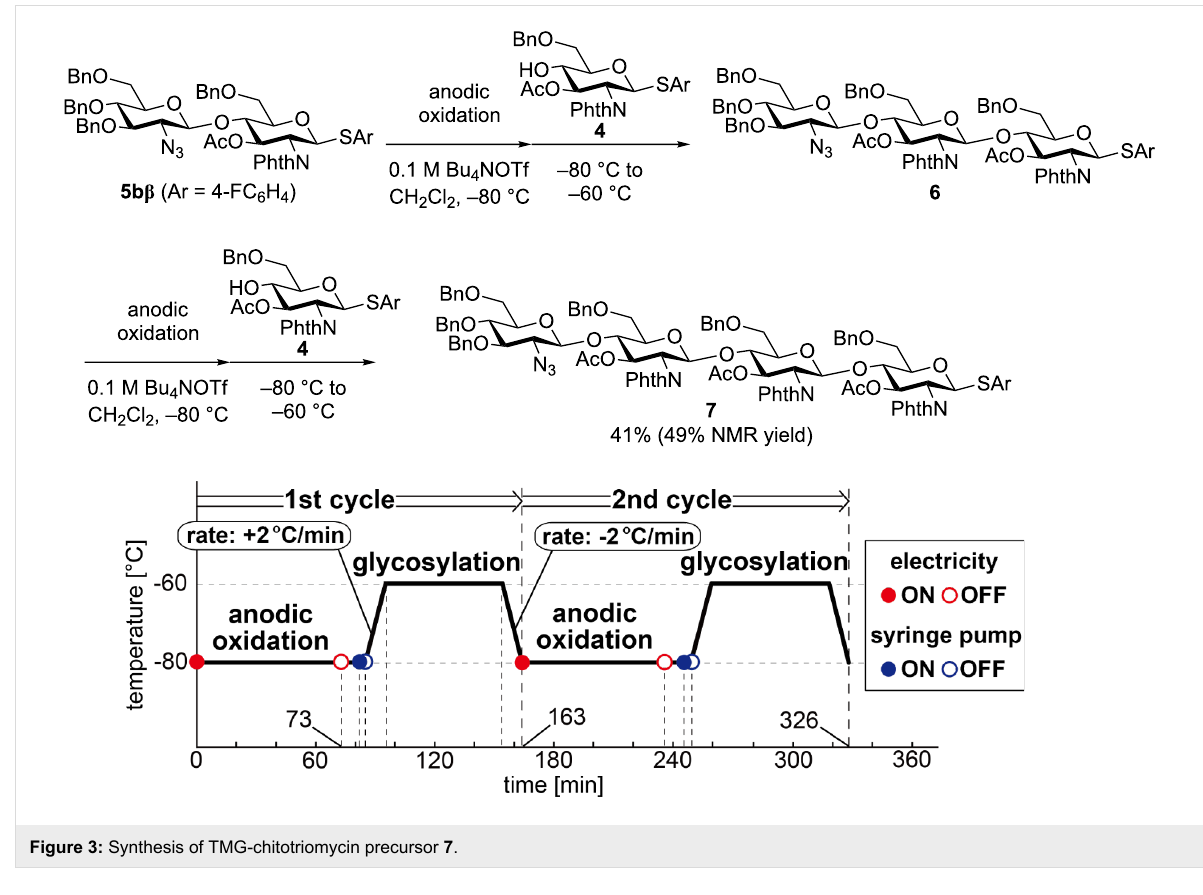
Figure 3: Synthesis of TMG-chitotriomycin precursor 7 .